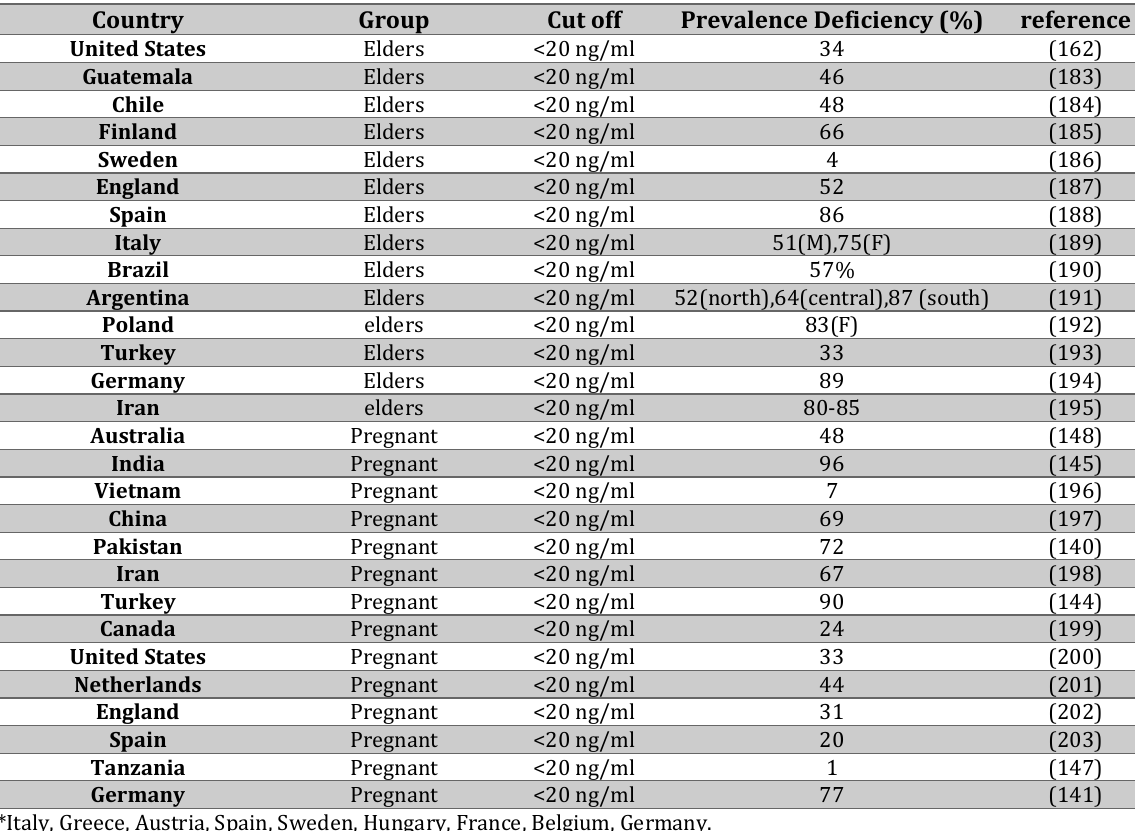
Continue Table 6. Prevalence of moderate vitamin D deficiency worldwide.